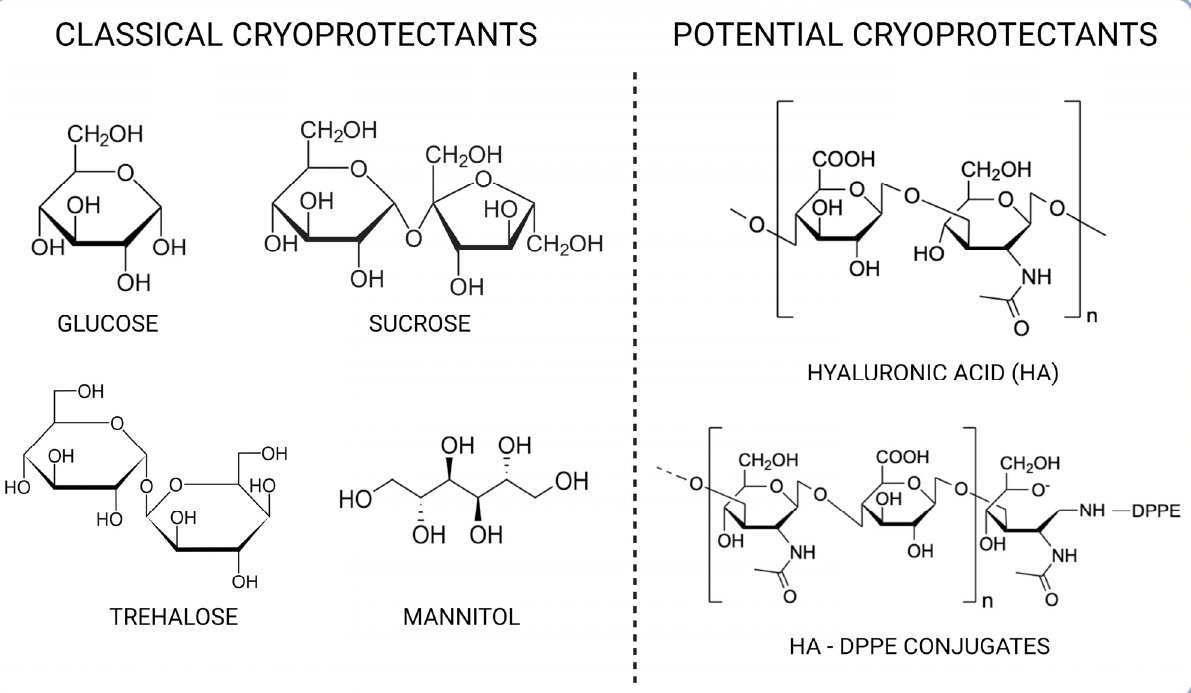
Figure 2. Chemical structures of the excipients used in this